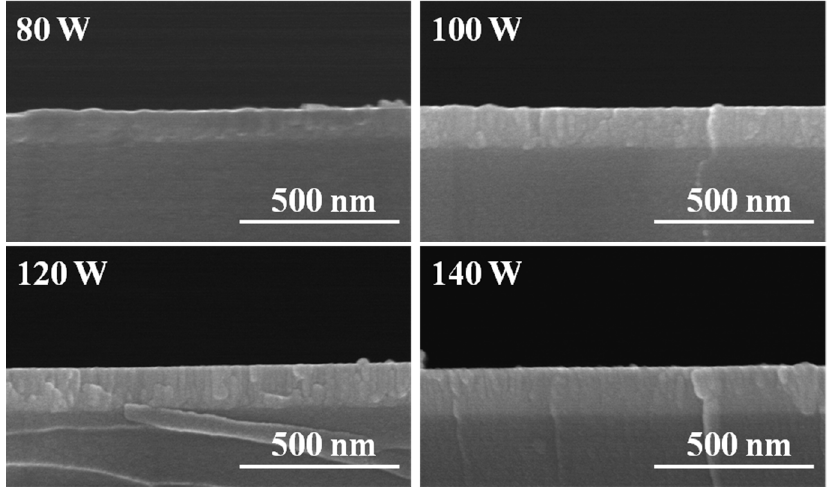
Figure 4. Cross-section observations of IGZO thin films as a function of deposition power of GZO ceramic